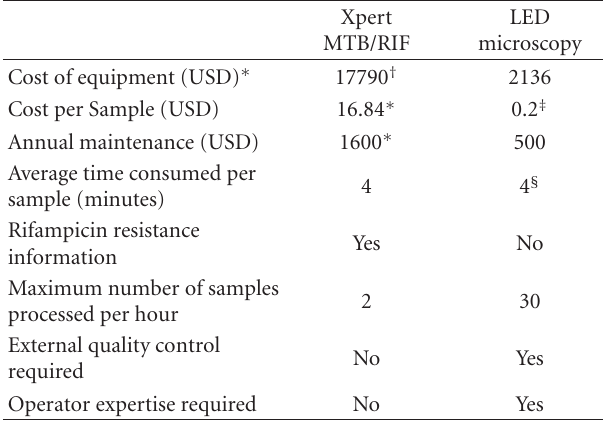
Xpert LED MTB/RIF